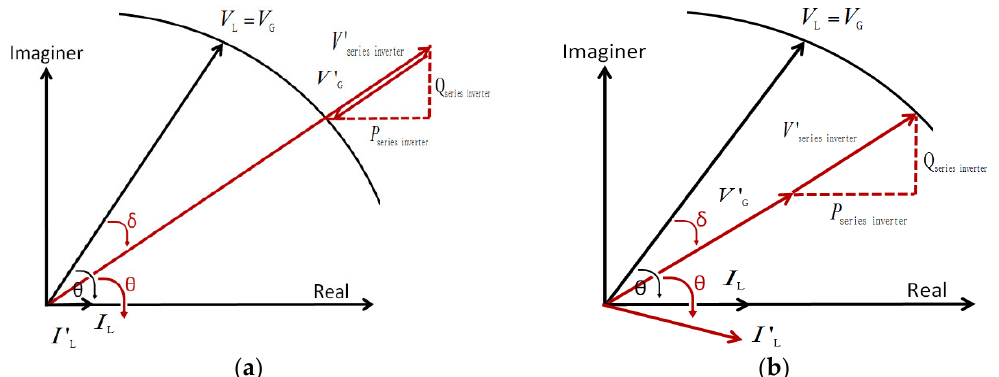
Figure 5. Phasor diagram for the series inverter: ( a ) overvoltage conditions; ( b ) undervoltage conditions.